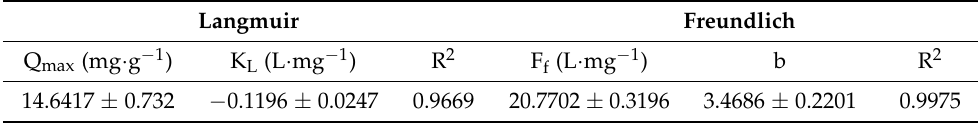
Table 4. LA-CZ adsorption isotherm parameters of